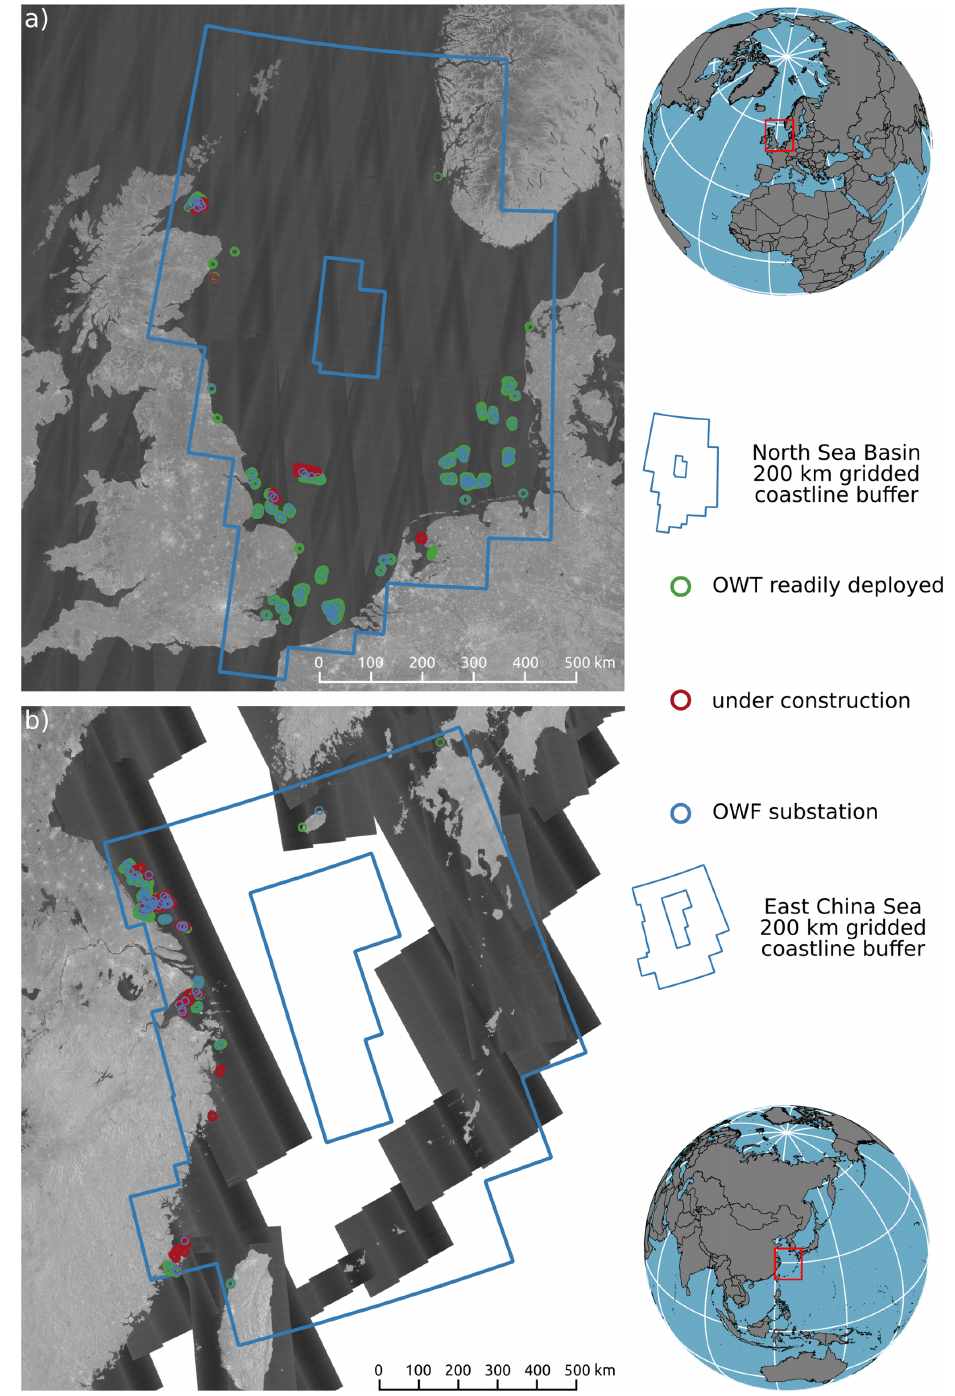
Figure 7. Overview of the ground truth sites’ boundaries and the hand-labelled object locations and deployment stages for the second quarter of 2021. Panel (a) shows the North Sea basin (NSB), and panel (b) shows the East China Sea (ECS).